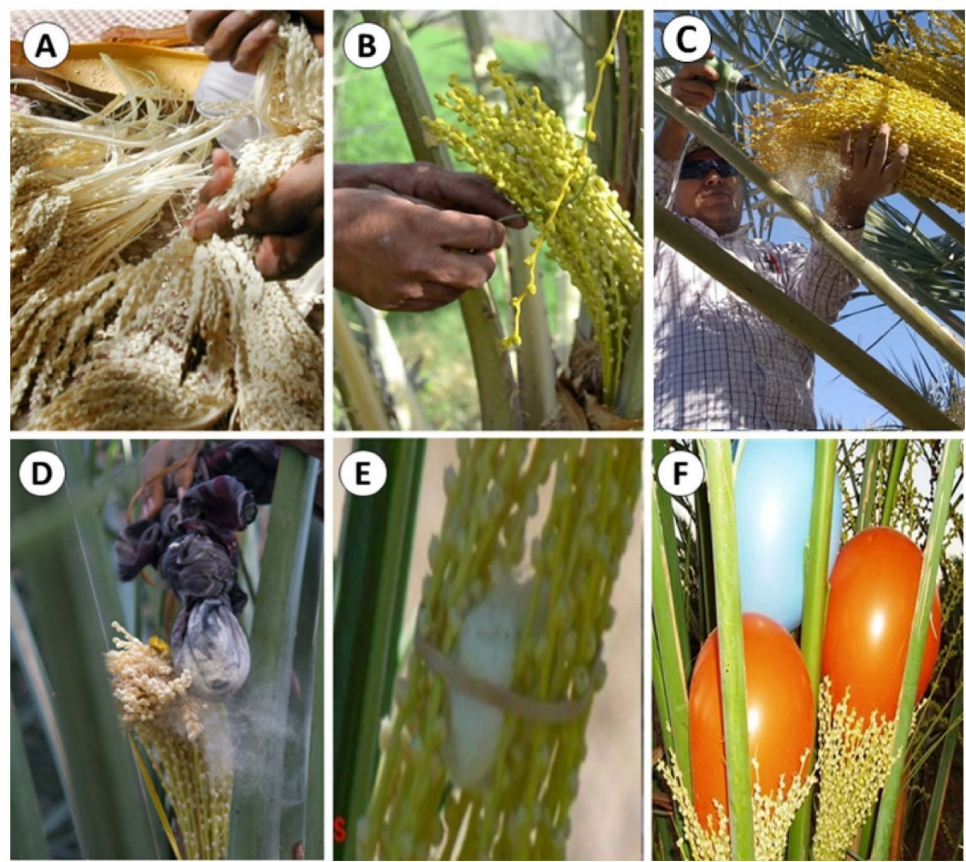
Figure 5. Pollination with male strands and dry pollen. ( A ) Separation of strands of a male inflores- cence. ( B ) Embedding of male strands in the middle of a female inflorescence and securing with a string for its containment. ( C ) Pollination using a squeeze bulb. ( D ) Use of a cloth filled with DPP. ( E ) Cotton pieces embedded in the female inflorescence. ( F ) Common party balloons containing DPP inside. Source: Images A, B, D, E, and F (Adapted from [16,63,64]). Image C (Photo by Ricardo Salom ó